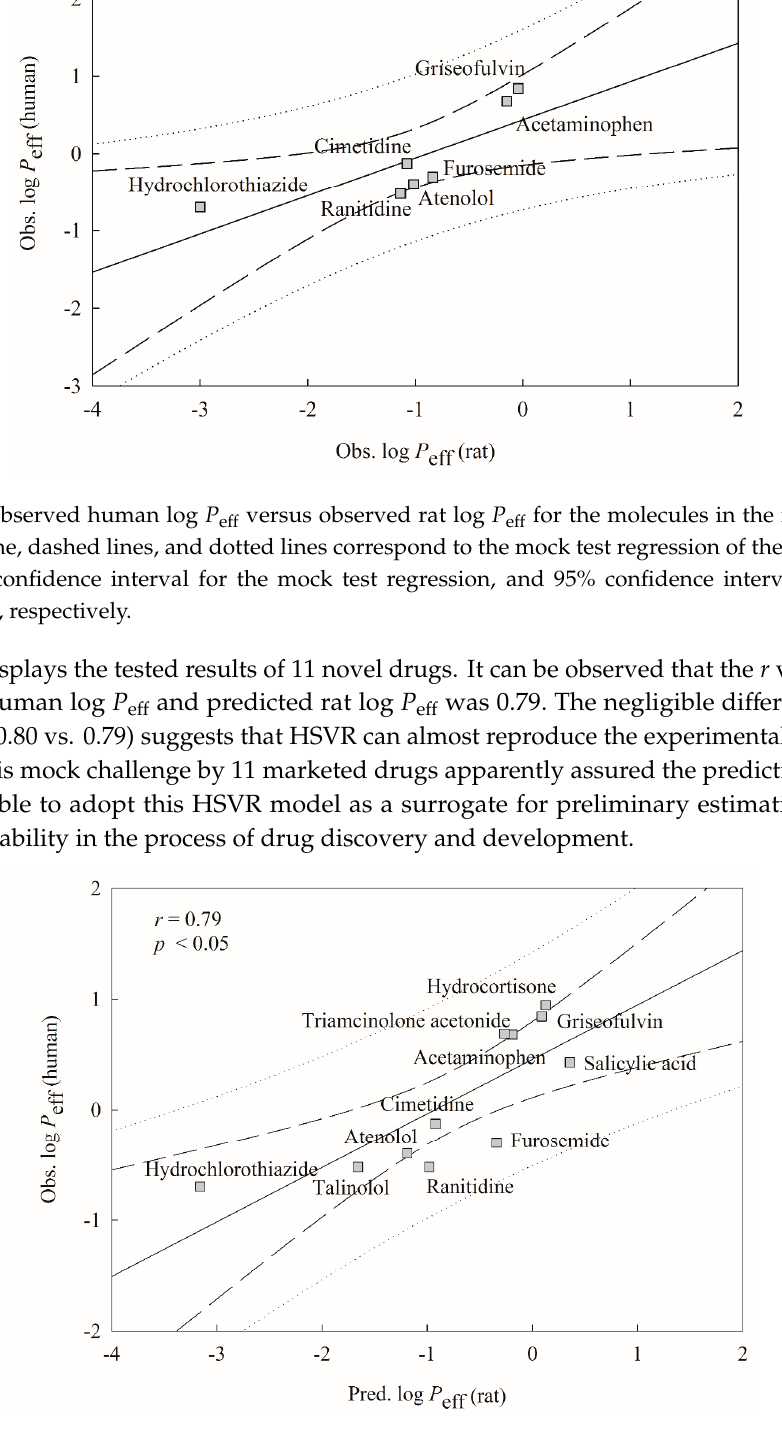
Figure 7. Observed human log P eff versus the rat log P eff predicted by HSVR for the molecules in the mock test. The solid line, dashed lines, and dotted lines correspond to the HSVR regression of the data, 95% confidence interval for the HSVR regression, and 95% confidence interval for the prediction, respectively.